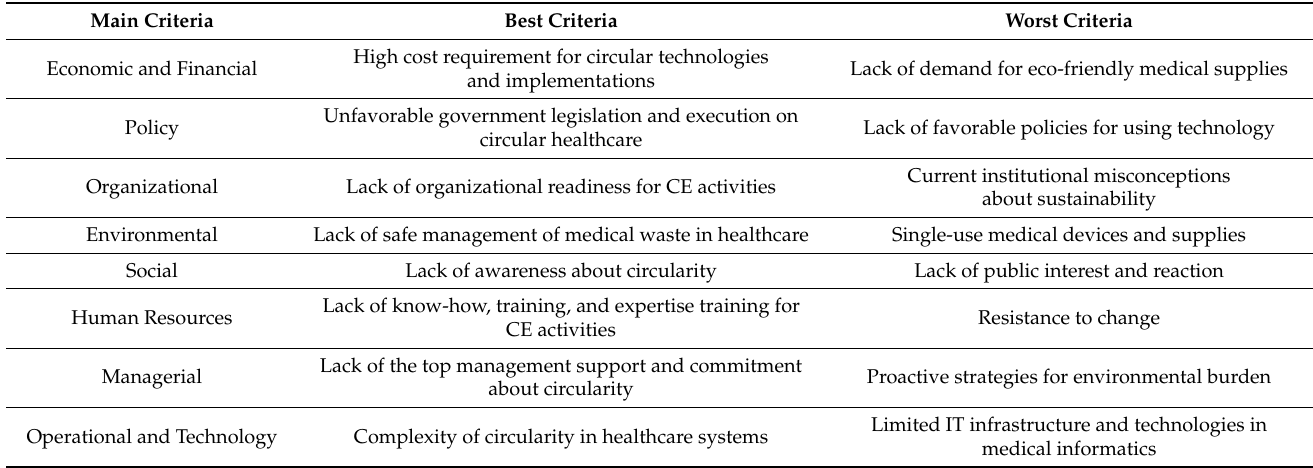
Table 3. The best and worst criteria for each main criterion.